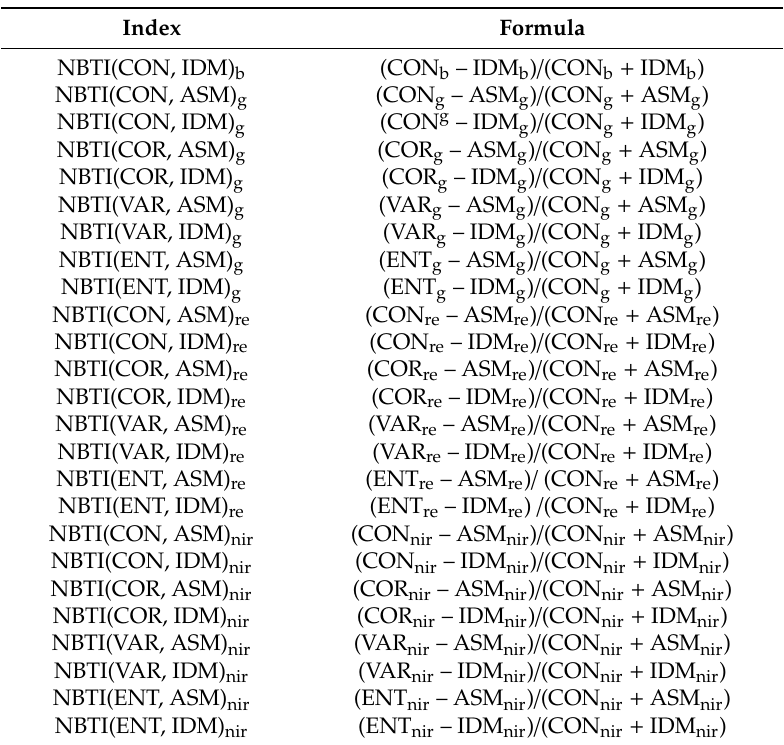
Table 2. Candidate textural indices for biomass estimation designed in this